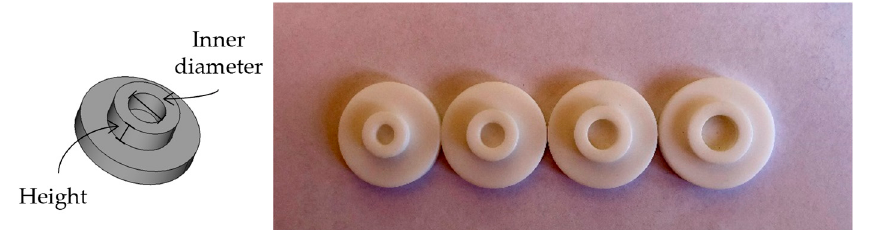
Figure 1. The 3D design and construction of the Teflon vessels with different inner diameters and heights. Table 1. Volume of the different Teflon vessels, deduced from the heights and inner radius.